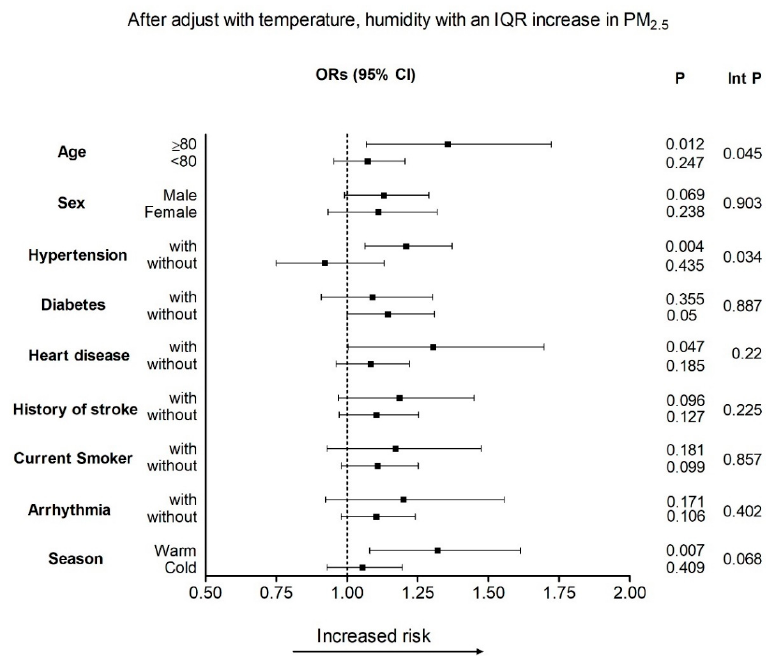
Figure 2. Odds ratios (ORs) for IQR increments in PM 2.5 on lag3 for different underlying diseases and seasons, after adjusting for temperature and humidity. Int p denotes the interaction p -value.